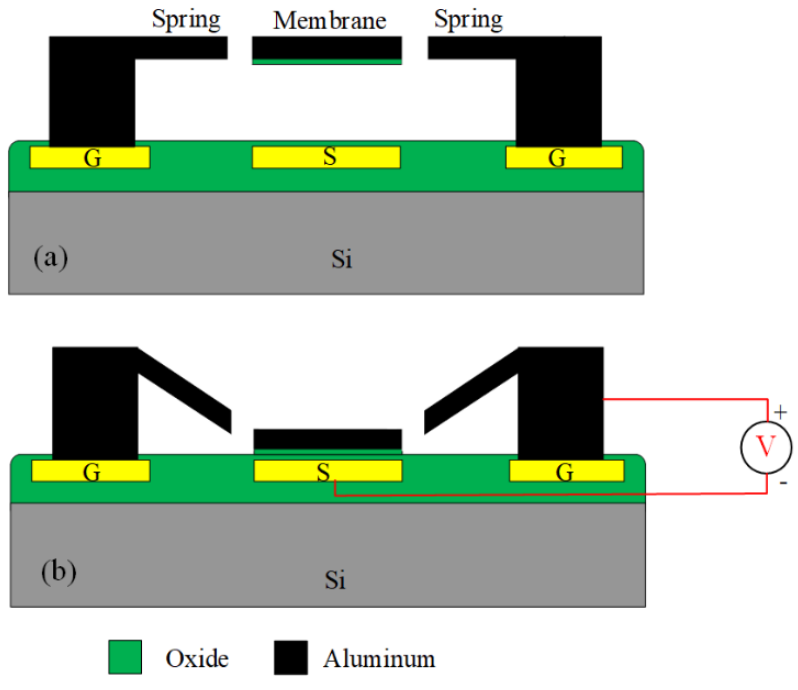
Figure 2. Cross-sectional view for the MSS: ( a ) in the on state; ( b ) in the off state.